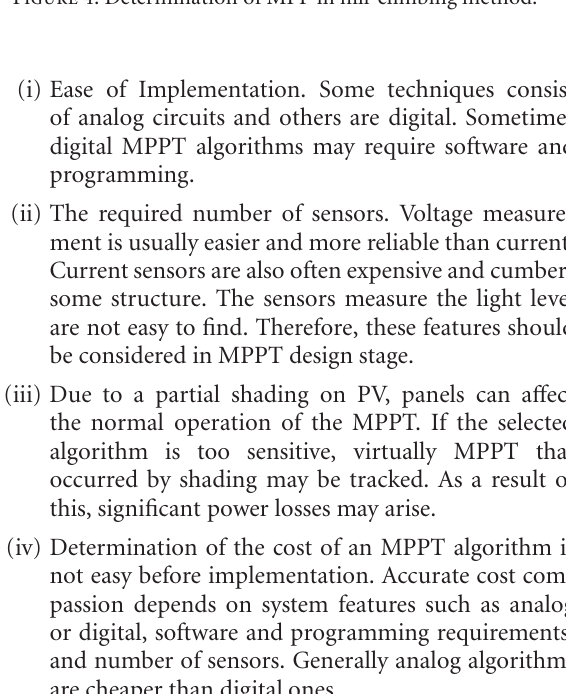
Figure 4: Determination of MPP in hill-climbing